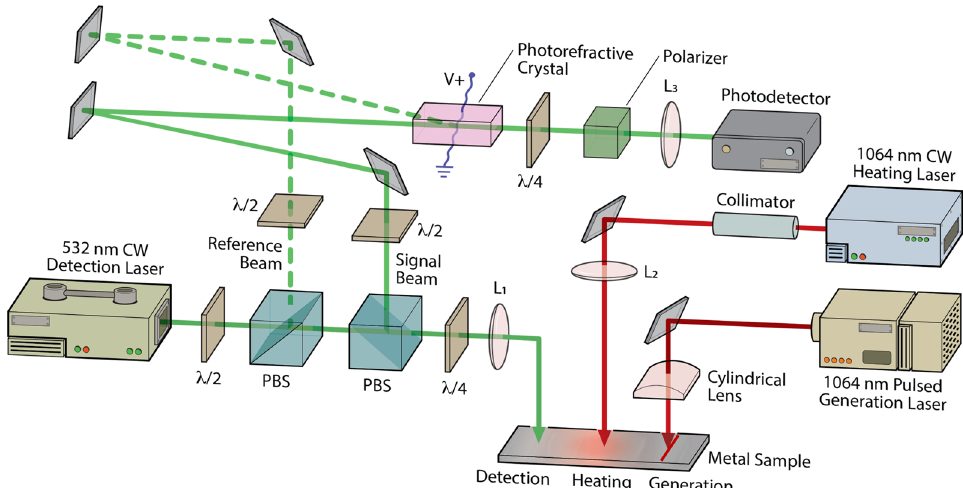
Figure 4. Schematic of the experimental setup depicting the three laser beams on the sample surface. The following abbreviations are used: PBS, polarizing beam splitter; λ/2, half-wave plate; λ/4, quarter-wave plate; L1, L2, L3, focusing